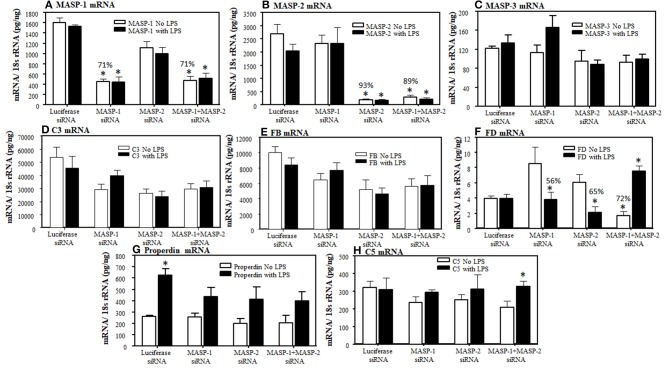
Effect of a long-term silencing of MASP-1 and MASP-2, in vivo with no disease, on expression of various AP complement components induced by LPS. The expression of AP complement components was measured by qRT-PCR. WT mice were injected with three doses of GalNAc-Luciferase-siRNA, GalNAc-MASP-1-siRNA, GalNAc-MASP-2-siRNA and GalNAc-MASP-1+MASP-2-siRNAs. At day 10, 3 mice from each group were injected with LPS and sacrificed at day 17 and 2 non-injected control mice were sacrificed at day 25. Liver from all mice examined for the expression of MASP-1, MASP-2, MASP-3, C3, FB, FD, Properdin, and C5. (A) MASP-1 (B) MASP-2 (C) MASP-3. (D) C3 (E) FB, (F) FD, (G) Properdin, and (H) C5. 18S rRNA was used as internal control and the values have been shown in pg/ng 18S rRNA. *p < 0.05 compared with mice treated with or without LPS. Liver from mice treated with or without LPS were cut into three pieces and the expression of complement components was examined separately and repeated two times from each piece. Total mice used in this study were 34 i.e., GalNAc-Luciferase-siRNA (n = 8), GalNAc-MASP-1-siRNA (n = 8), GalNAc-MASP-2-siRNA (n = 9) and GalNAc-MASP-1+MASP-2-siRNAs (n = 9). Data are expressed as Mean ± SEM *p <0.05 considered significant.